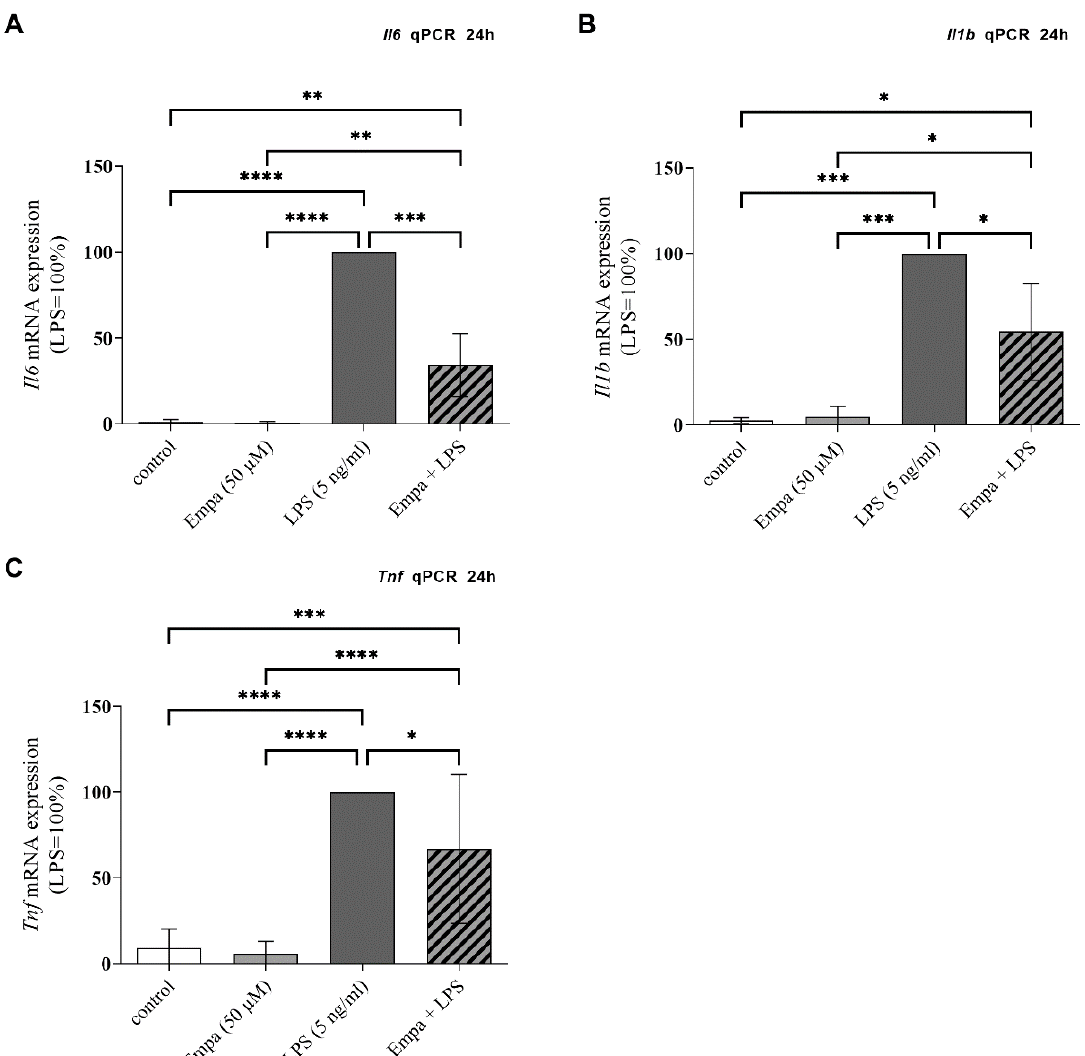
Figure 3. The mRNA expression of pro-inflammatory cytokines by primary microglia was measured using qPCR after stimulation for 24 h. Empagliflozin significantly reduced the LPS-induced mRNA expression of Il6 ( A ), Il1b ( B ) and Tnf ( C ). Stimulation with empagliflozin alone did not affect the mRNA expression in comparison to the control (asterisks indicate all significant differences; * p ≤ 0.05, ** p ≤ 0.01, *** p ≤ 0.001, **** p ≤ 0.0001; one-way ANOVA, followed by Tukey test; F-value = 77.41 ( A ), 30.69 ( B ), 32.72 ( C ); n ≥ 3).